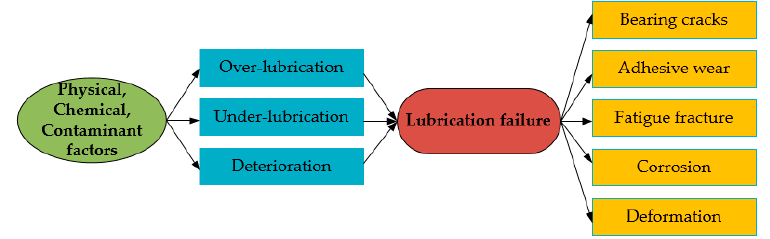
Figure 12. Analysis of lubrication failure of wind power bearings [70,109].